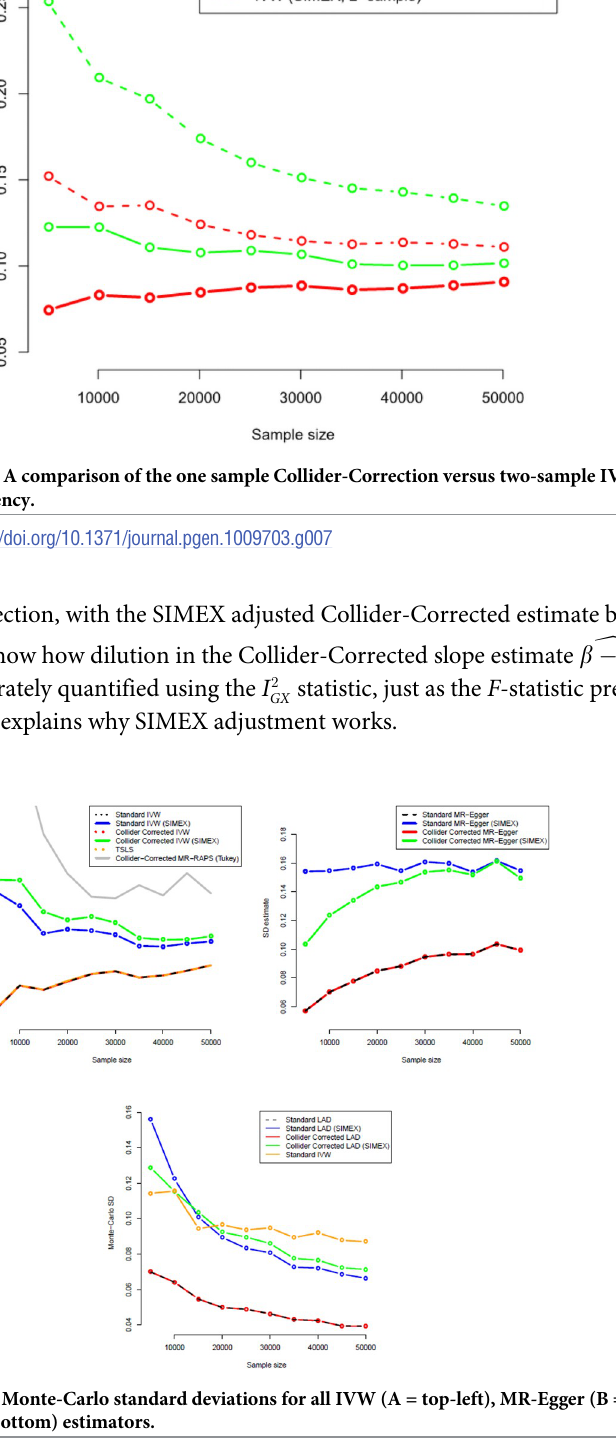
Fig 8. Monte-Carlo standard deviations for all IVW (A = top-left), MR-Egger (B = top-right) and LAD regression (C = bottom) estimators.